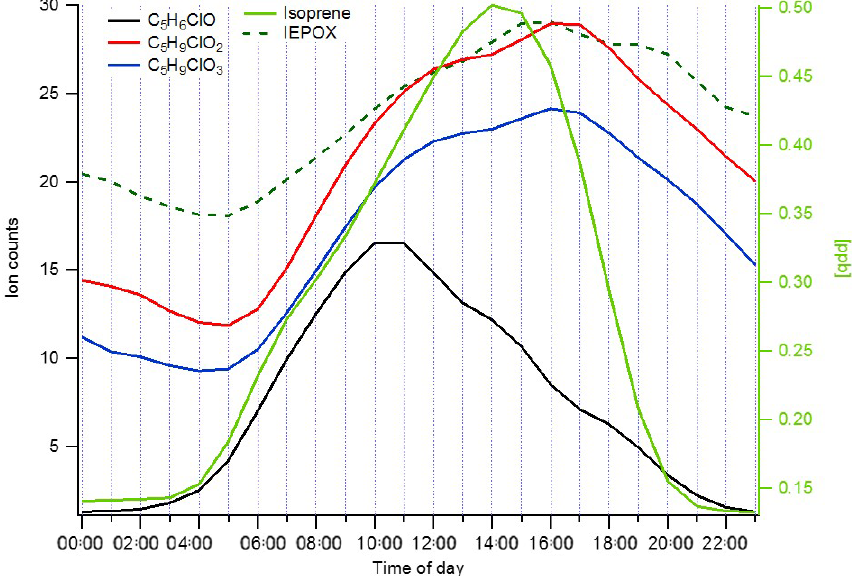
Figure 10. Mean diurnal profiles of isoprene (right y axis) and its OH oxidation product (IEPOX) and chlorine atom oxidation products CMBO, C 5 H 9 ClO 2 and C 5 H 9 ClO 3 (left y